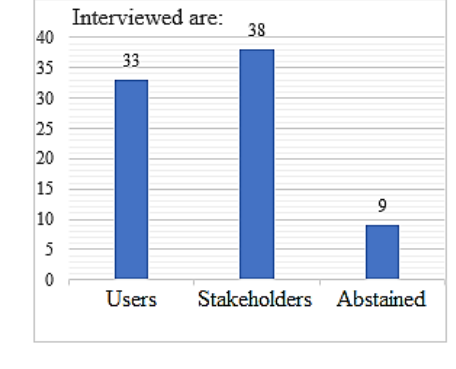
Fig. 1. Conducting interviews.